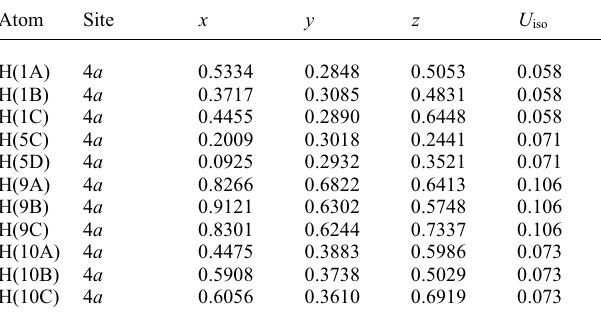
Table 2. Atomic coordinates and displacement parameters (in Å 2 )